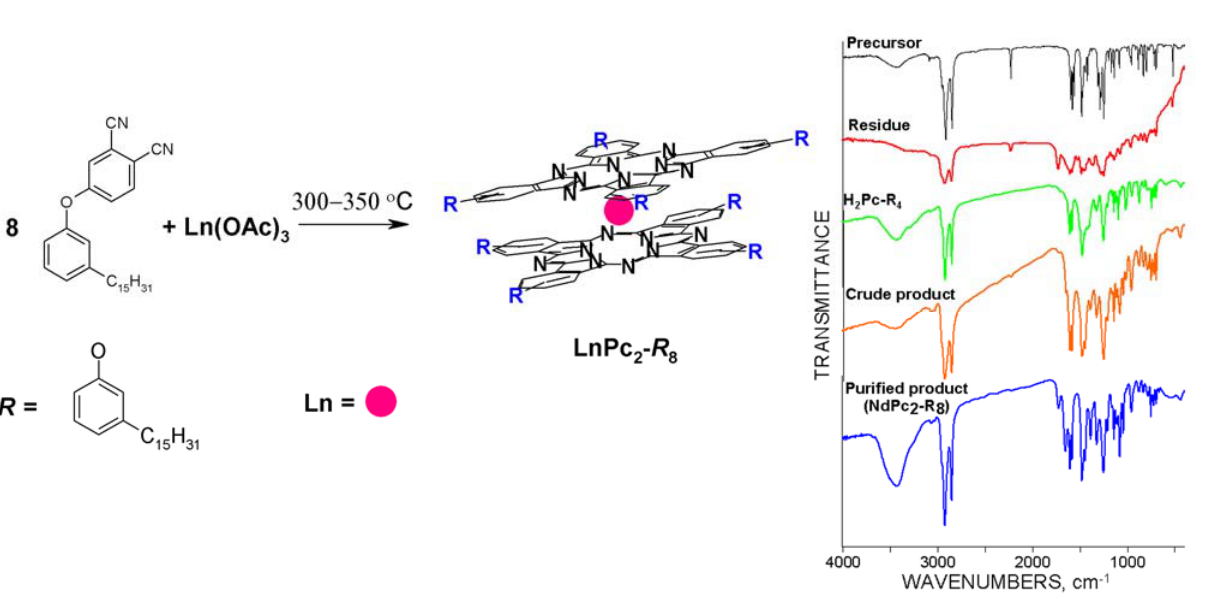
Figure 4. Synthesis of lanthanide bis-phthalocyanines functionalized by pentadecyl- phenoxy-groups, featuring the hypothetical molecular structure of the target complex. On the right, FTIR spectra illustrating the composition of the post-reaction